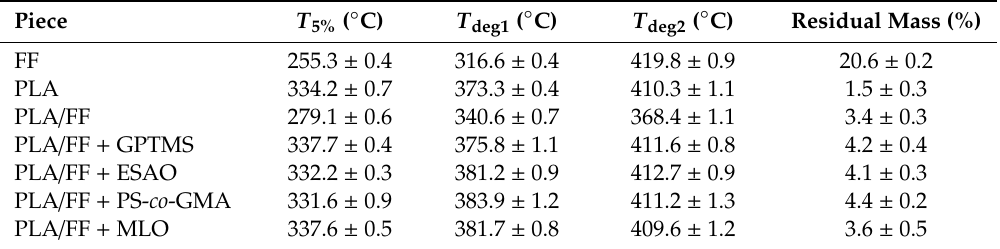
Table 4. Main thermal degradation parameters of the polylactide (PLA) / flaxseed fiber (FF) pieces compatibilized with (3-glycidyloxypropyl) trimethoxysilane (GPTMS), epoxy-based styrene-acrylic oligomer (ESAO), poly(styrene- co -glycidyl methacrylate) (PS- co -GMA), and maleinized linseed